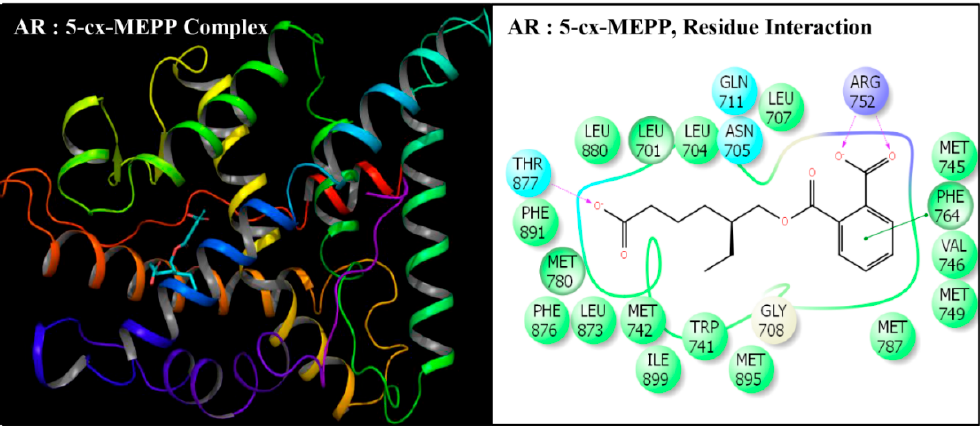
Figure 6. Ribbon diagram representing the docking pose of human androgen receptor (AR) with mono-(2-ethyl-5-carboxypentyl)phthalate (5-cx-MEPP) (left panel). The interactions of ligand (5-cx-MEPP) with amino-acid residues in the binding pocket of AR (right panel).